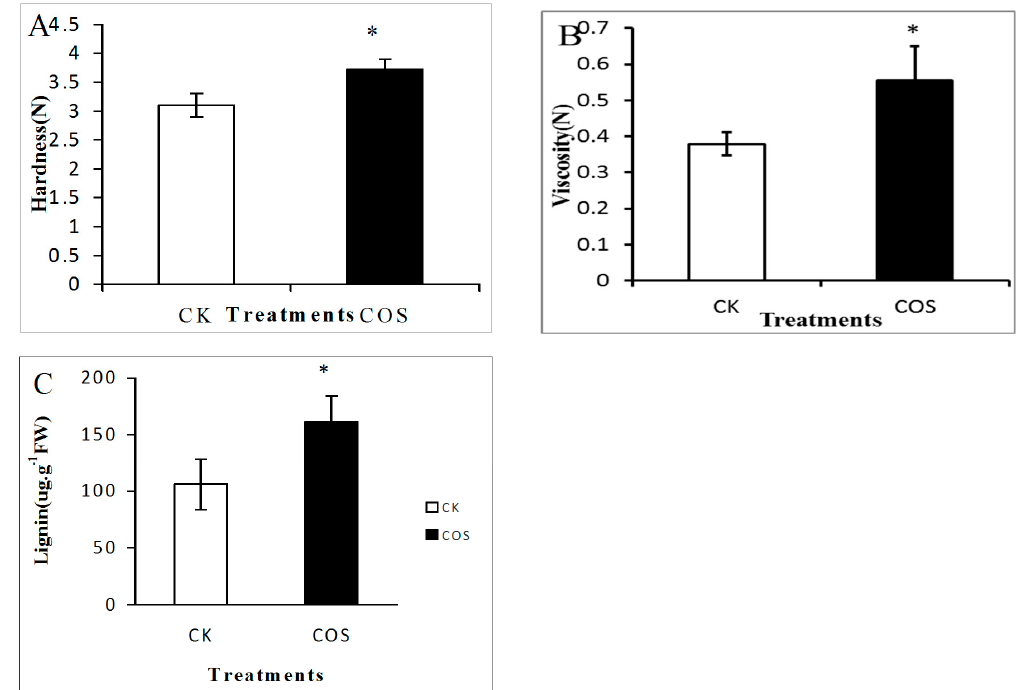
Figure 1. Effect of COS pre-harvest treatment on hardness ( A ); viscosity ( B ) and lignin ( C ) content of strawberry fruit. Data represent the means ± SD. The * represent means significantly different according to T test at p < 0.05 level. CK: Spraying water pre-harvest; COS: Spraying COS pre-harvest.